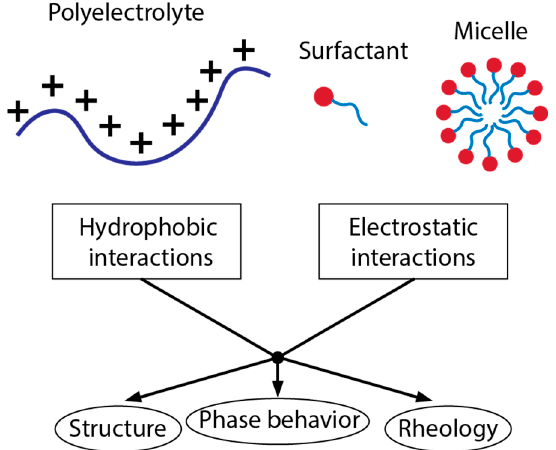
Figure 1. Schematic of how molecular interactions of polyelectrolyte and surfactant and surfactant micelle systems lead to structure, phase behavior, and rheological properties.